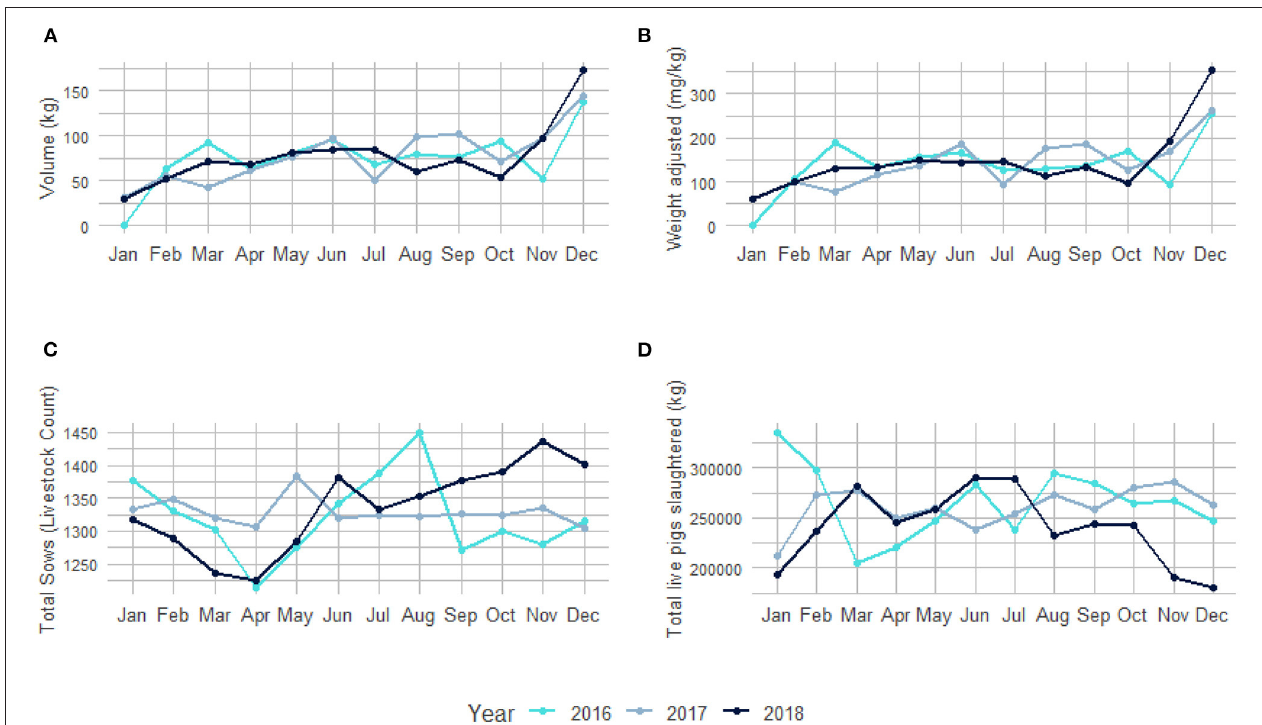
FIGURE 3 | Seasonal variation of antibiotic usage over three years (2016–2018). (A) Total volume (kg) of antibiotics purchased per month. (B) Antibiotic usage adjusted per animal biomass (mg/kg) per month. (C) Total sows (livestock count) present on the pig farm used for breeding purposes per month. (D) Total live weight (kg) of all pigs slaughtered per month ( Supplementary Tables 2, 6